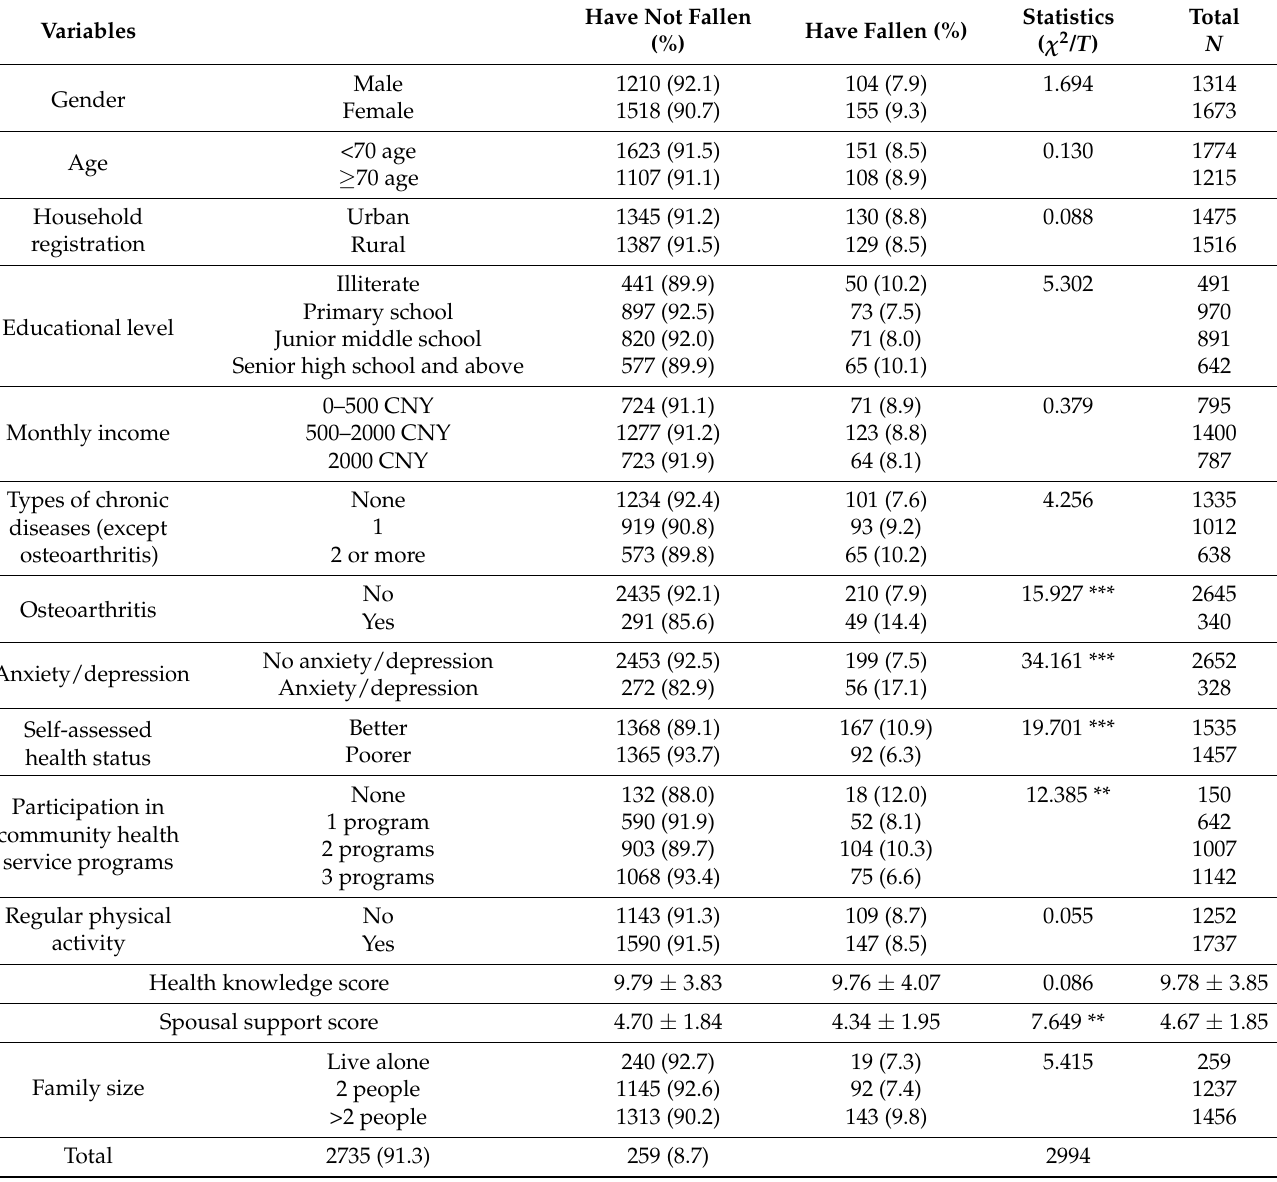
Table 1. Univariate analysis of falls and injuries in the elderly ( n =